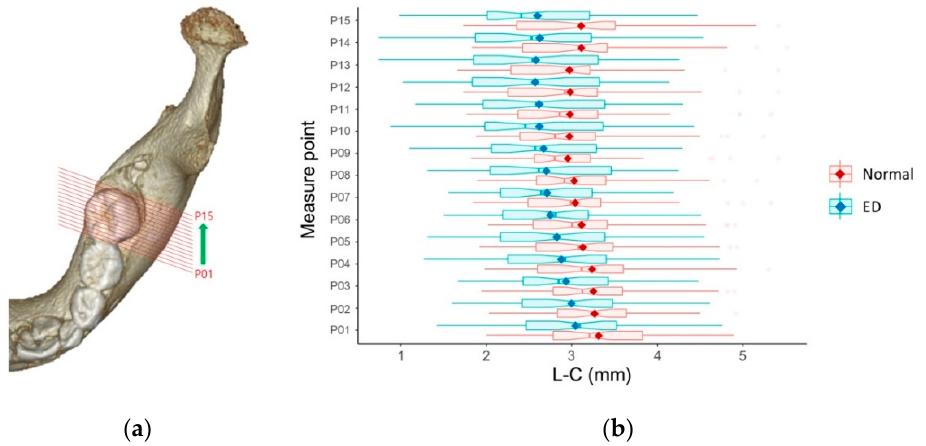
Figure 5. Buccolingual position of the mandibular canal in relation to PM1. ( a ) Reconstructed axial view of mandible with PM1 and measurement points; ( b ) Box plots for comparison of mean values of the distance from the outer margin of the lingual cortex to the center of the mandibular canal (L–C) at each measurement point in the normal and eruption disturbance (ED) groups. The dots in the center of the boxes are mean values. These values indicate the buccolingual position of the mandibular canal at each measurement